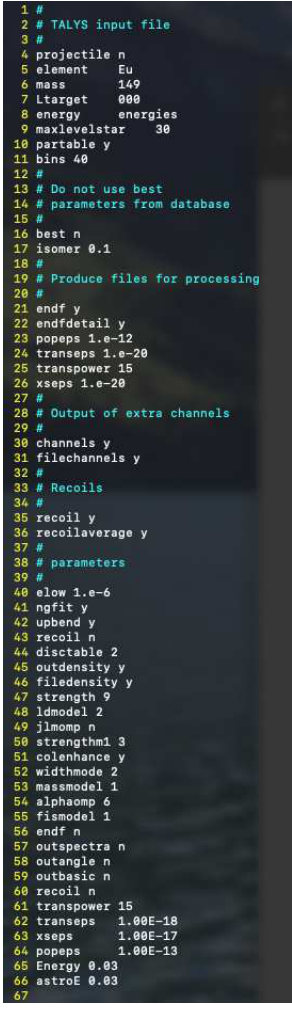
Figure 6: Typical TALYS input file for the calculation of the 30 keV MACS of 149